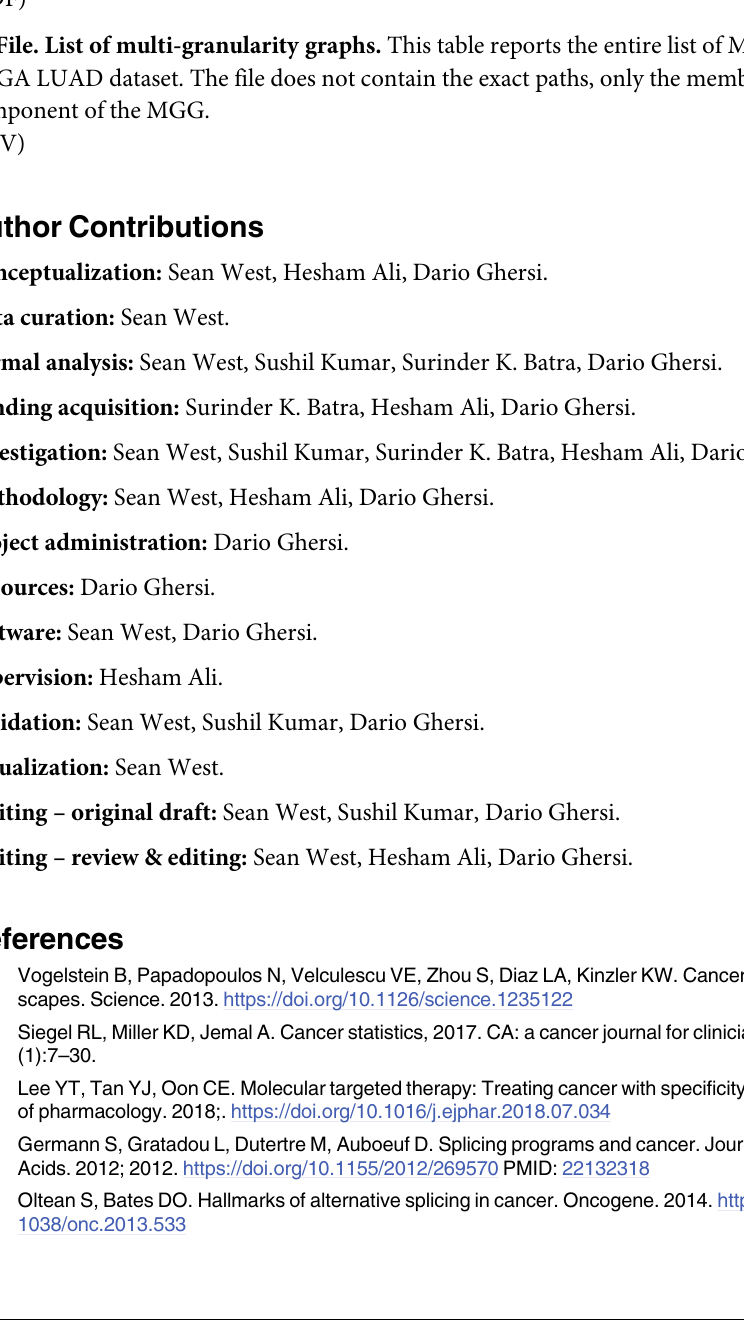
S1 Fig. Enrichment term cluster membership across granularities. Counts of genes belong- ing to each enrichment cluster for the gene, isoform (splice variant), and MGG granularities are displayed as bar lengths. Missing bars does not indicate no membership, just insignificant enrichment of any term in the cluster.